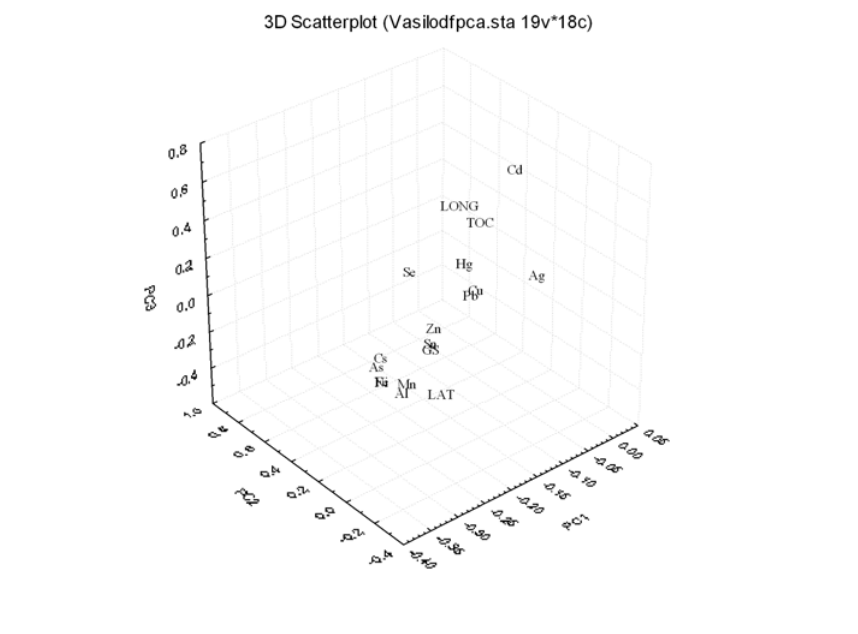
Fig. 3 Scatterplot of loadings corresponding to the first three principal components (Orthogonal Fuzzy